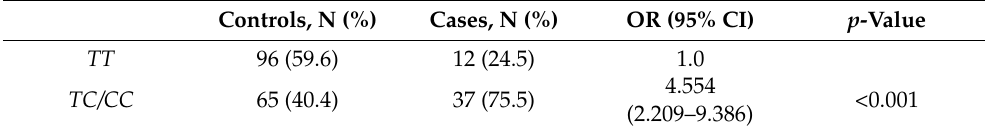
Table 4. Distribution of CYP19A1 codon 39 polymorphisms in women with endometriosis and controls (fertile women).